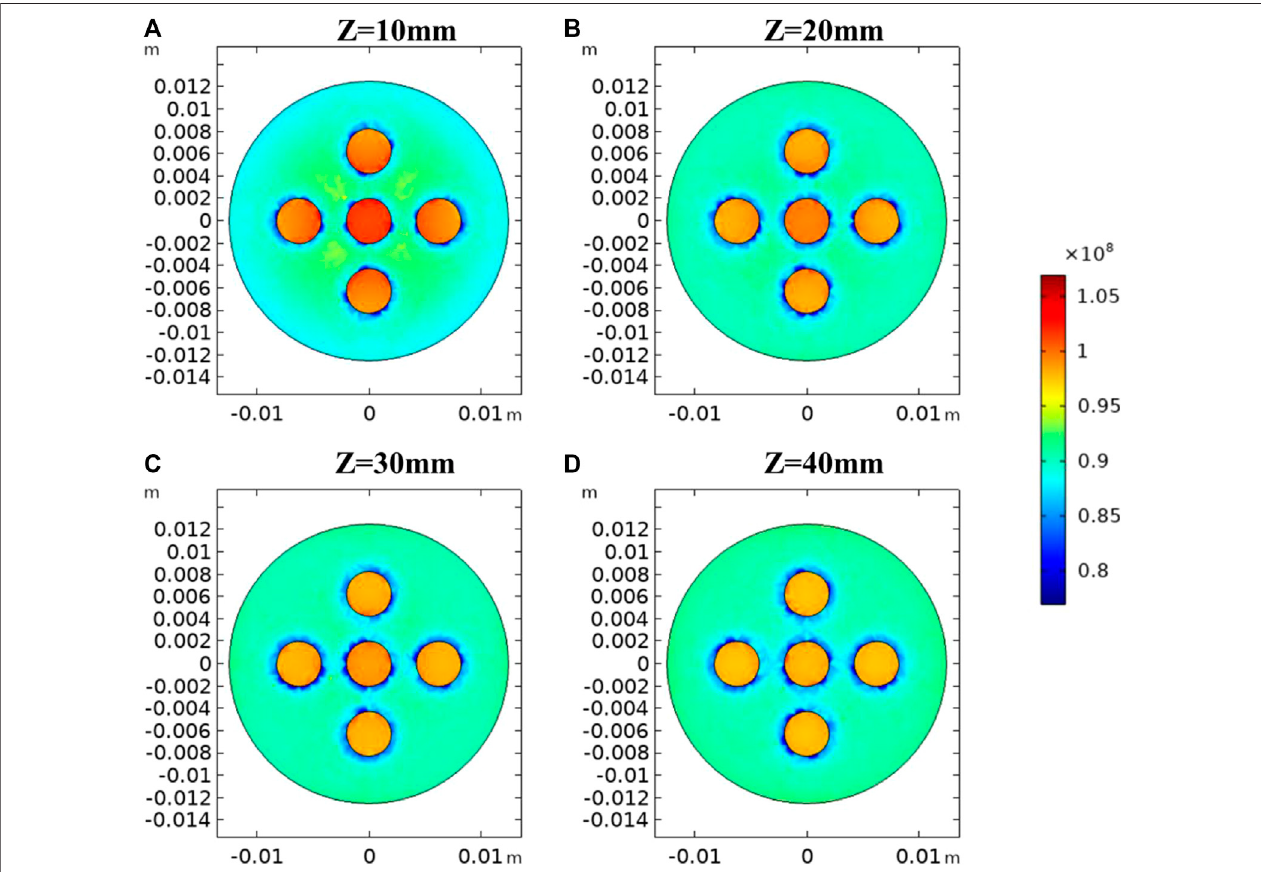
FIGURE 10 | Distribution of axial stresses in X-Y planes of (A) Z (cid:2) 10 mm, (B) 20 mm, (C) 30 mm, and (D) 40 mm in the base case.